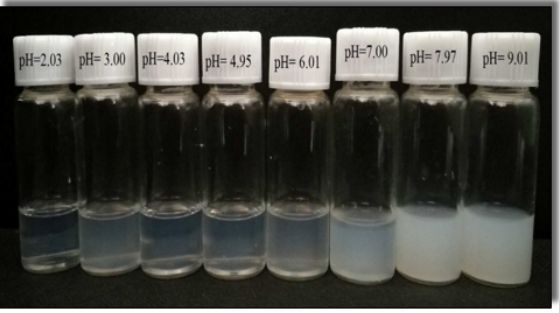
Figure 7. Phase behaviour of CTAB-citric acid (CTAB-CA) solution at different pH